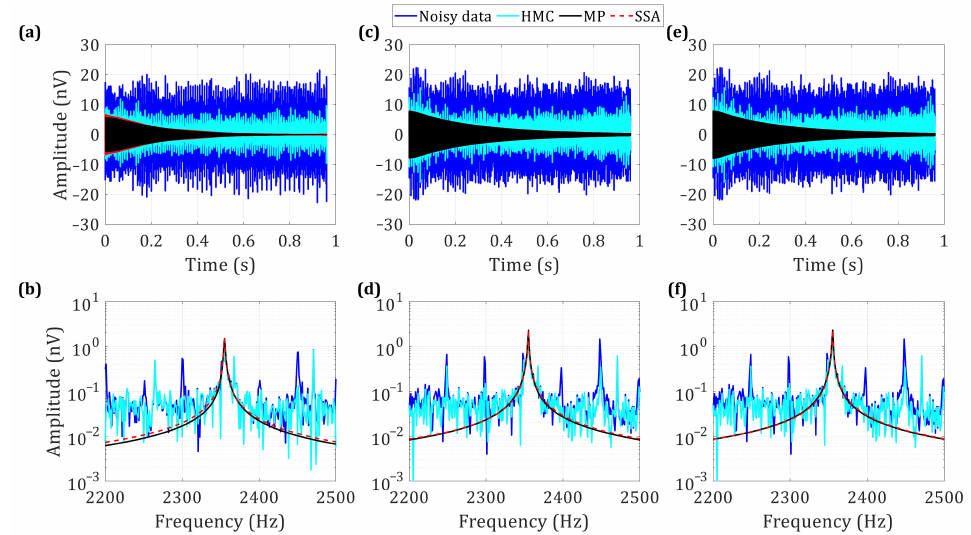
Figure 7. Comparison of denoising results of the MP, SSA, and HMC algorithms with T ∗ 300, and 400 ms: ( a ) T ∗ = 200 ms, ( b ) is the corresponding spectrum; ( c ) T ∗ 2 corresponding spectrum; ( e ) T ∗ = 400 ms, ( f ) is the corresponding 2